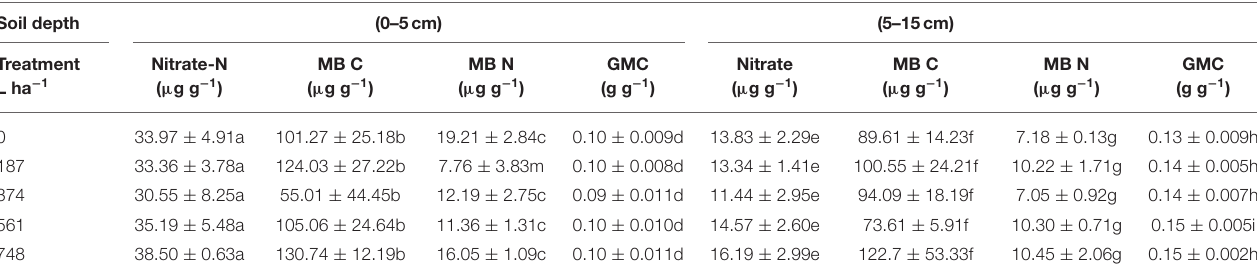
TABLE 3 | Effect of lactobionate application rates on soil nitrate-N, microbial biomass C and N and gravimetric moisture content (GMC) across soil depths (0–5cm, 5–15cm) for the corn field trial. Soil